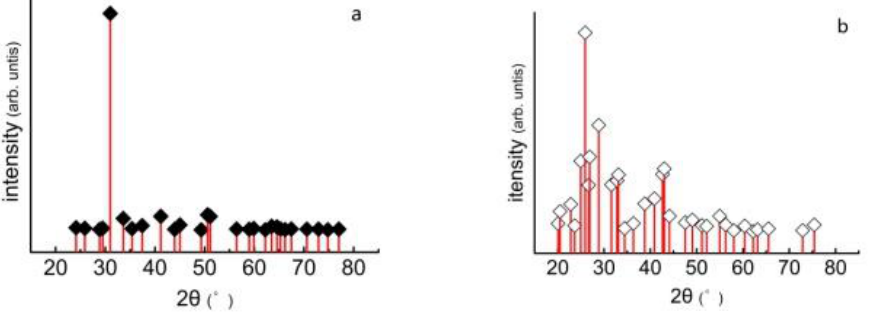
Figure 1. XRD peak positions of dolomite CaMg(CO 3 ) 2 ( a ) and barite BaSO 4 ( b ) in the